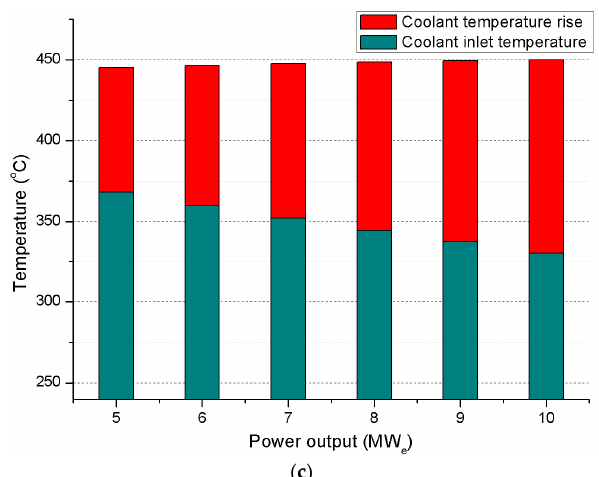
Figure 11. Coolant inlet temperature and coolant temperature rise for different power output. ( a ) BOC ( b ) MOC ( c ) EOC.